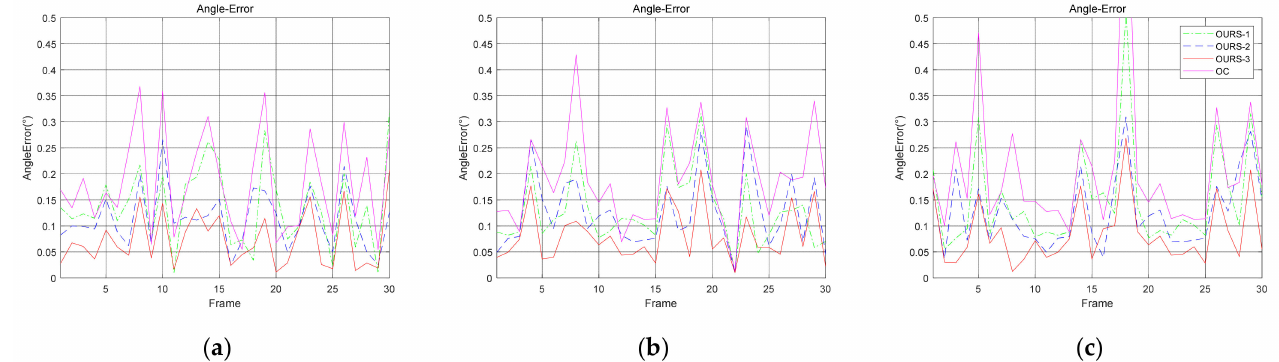
Figure 5. This is a figure showing some examples of simulations for the angle error of the normal vector. ( a ) The angle error of the normal vector when the variance in the image feature noise is 2; ( b ) The angle error of the normal vector when the variance in the spatial structure noise is 20; ( c ) The angle error of the normal vector at z -axis coordinates of 6 m. Table 1. This is a table about the mean error of the normal vector in the curves under different simulation conditions.